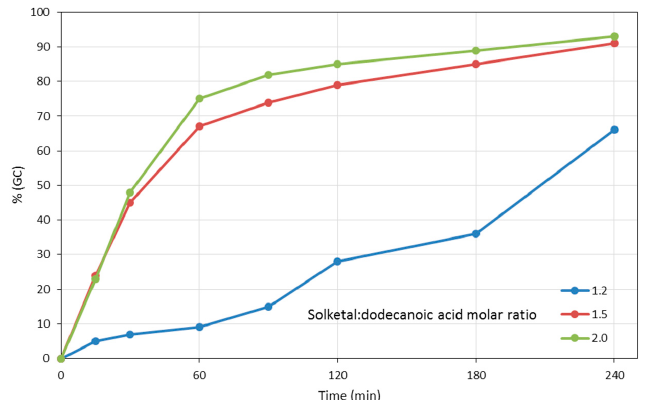
Figure 1. Time-dependent formation of (2,2-dimethyl-1,3-dioxolan-4-yl)methyl dodecanoate ( 2 ) at T = 60 °C in the presence of 5% PTSA with different solketal-dodecanoic acid molar ratios. Four different free fatty acids (RCH 2 CO 2 H, R = C 6 H 13 , C8:0; C 10 H 21 , C12:0; C 14 H 29 , C16:0; C 16 H 33 , C18:0) were reacted with 1.5 molar equivalents of solketal in the presence of 5 wt % of PTSA at 60 ˝ C and without added solvents (Equation (1)).